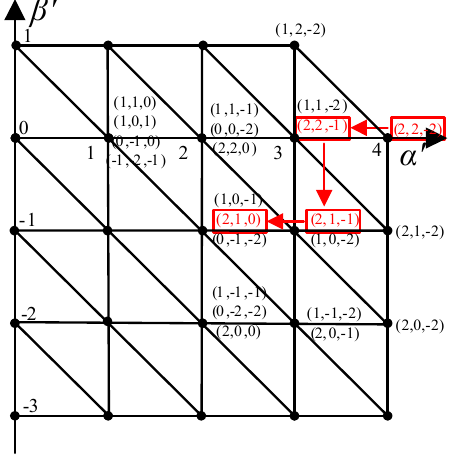
Figure 14. Realization of vector (2, − 1).